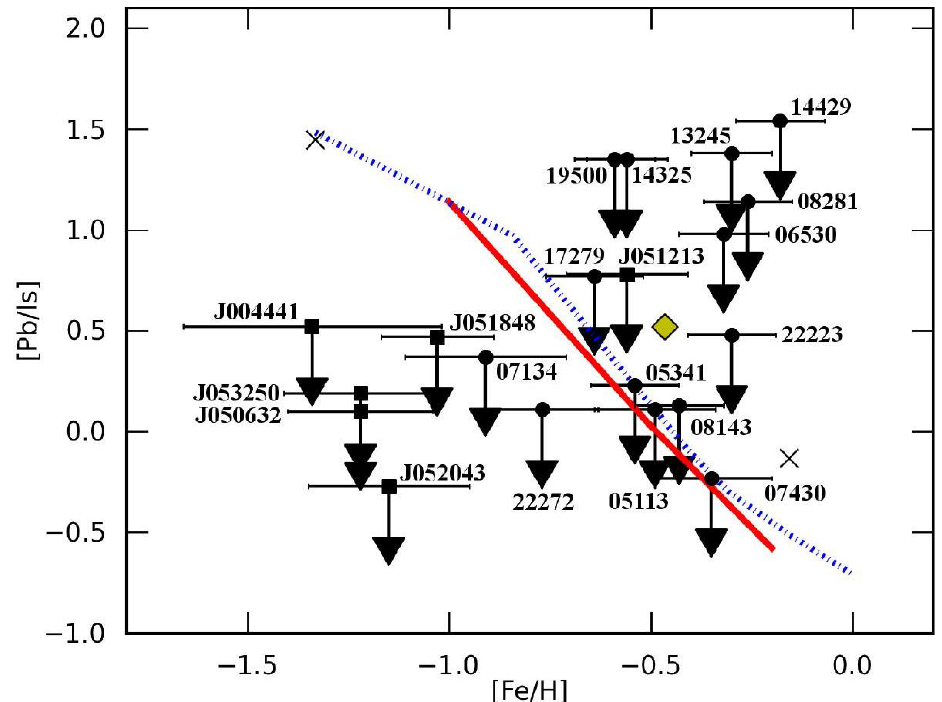
Figure A1. A reproduction of Figure 14 from [25]. The figure shows the observed [Pb up /hs] (upper panel) and the [Pb up /ls] (lower panel) versus [Fe/H] results of the sample of stars considered in [25]. The observed abundance upper limits are plotted together with the predictions of the STAREVOL models [38], Mount Stromlo models [36], and FRUITY models [42]. The black horizontal lines represent the [Fe/H] uncertainty of the displayed stars. See Section 3 and [25] for more